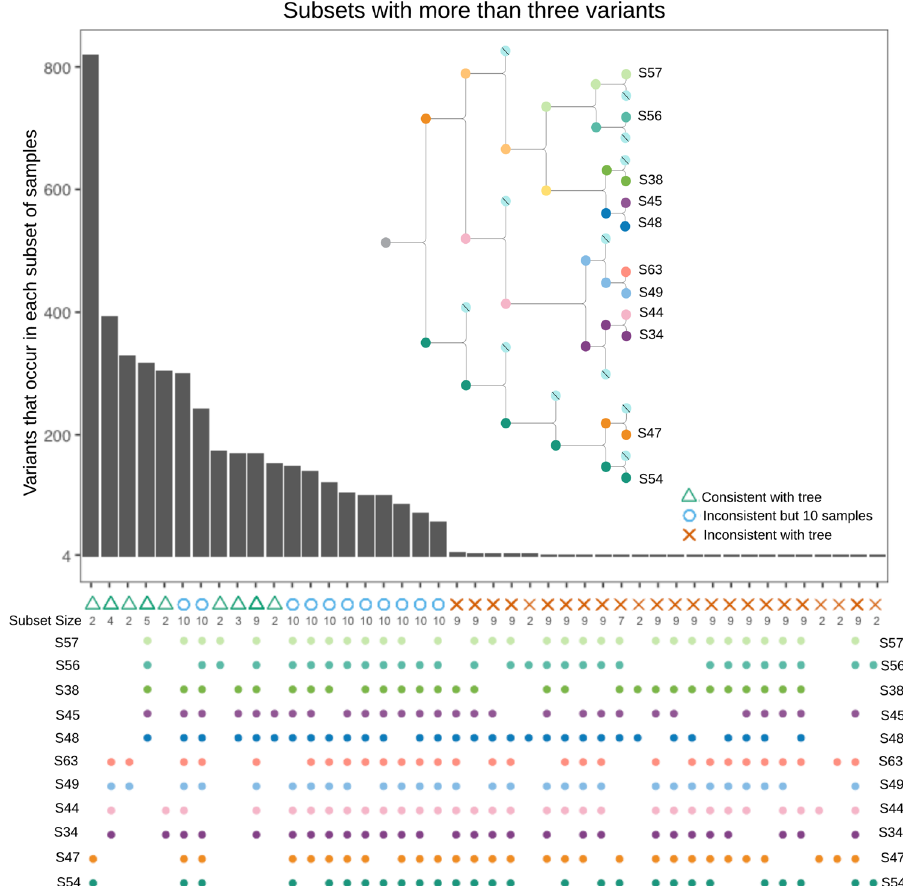
Fig. 5 Number of variants called by HaplotypeCaller within each subset. There is a clear separation of subsets that are consistent with the tree